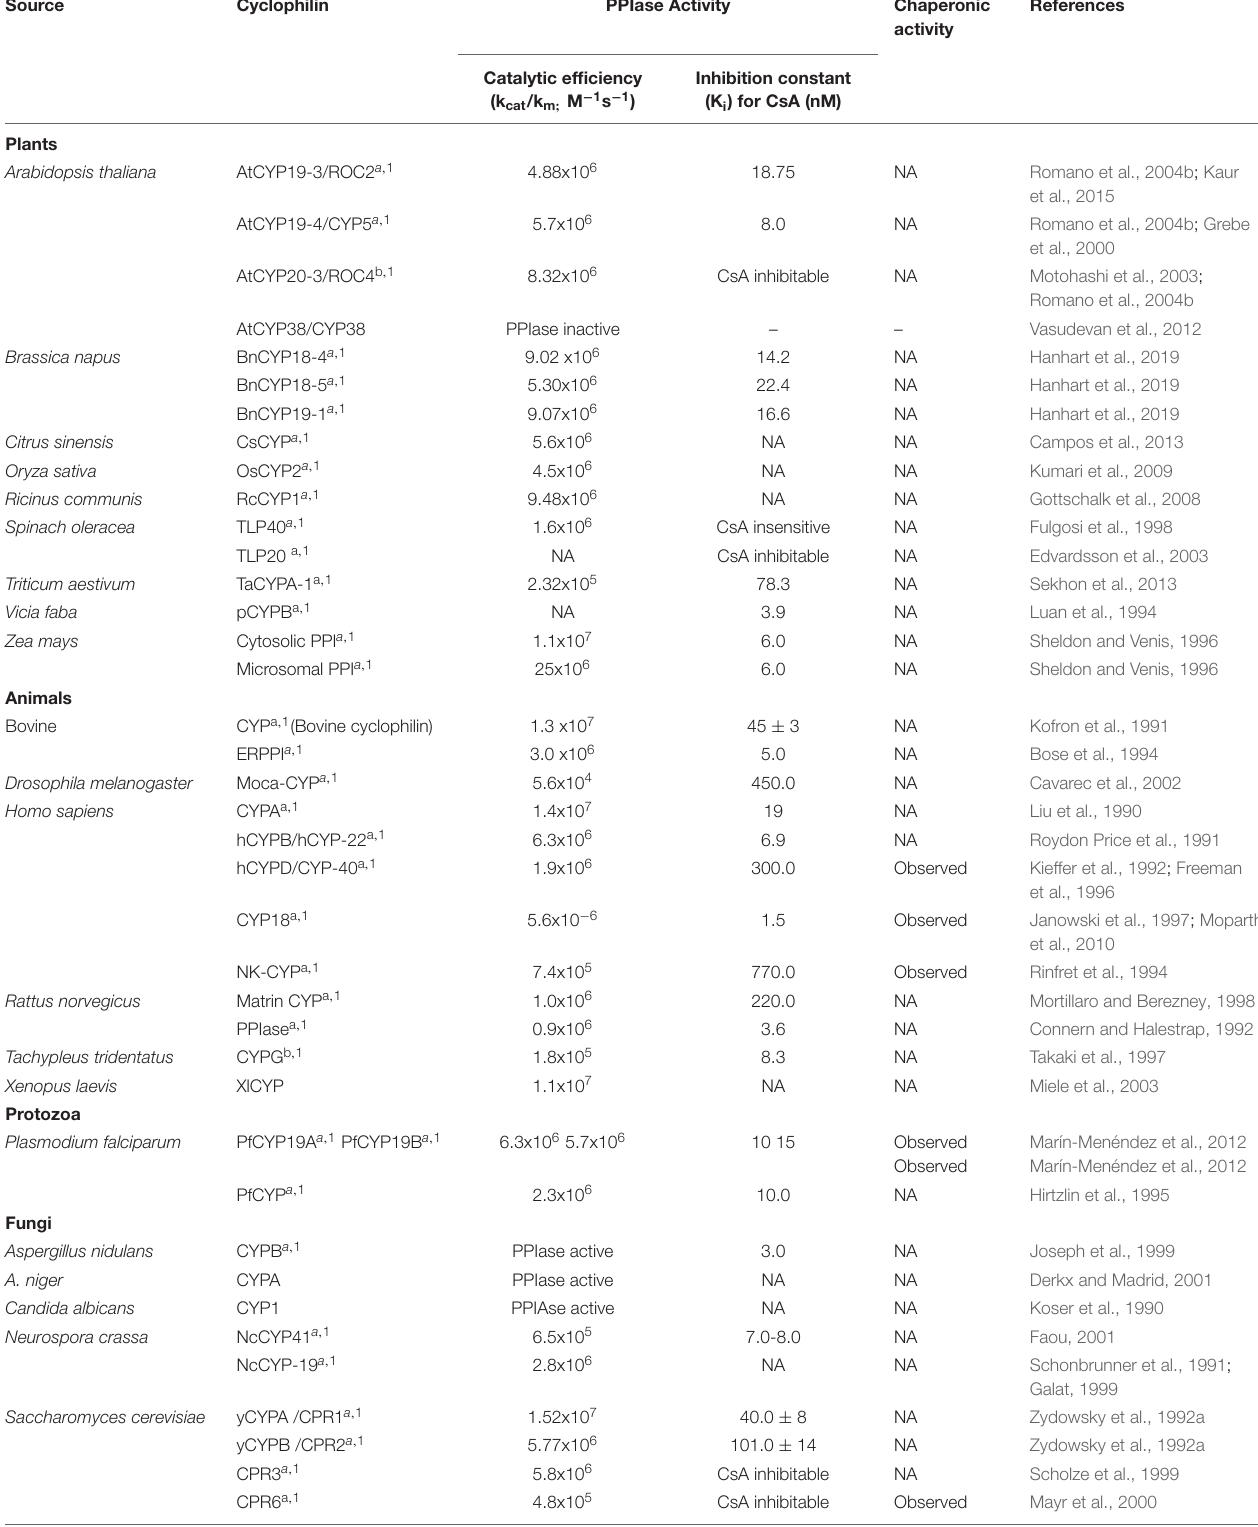
TABLE 6 | Biochemical characteristics of different